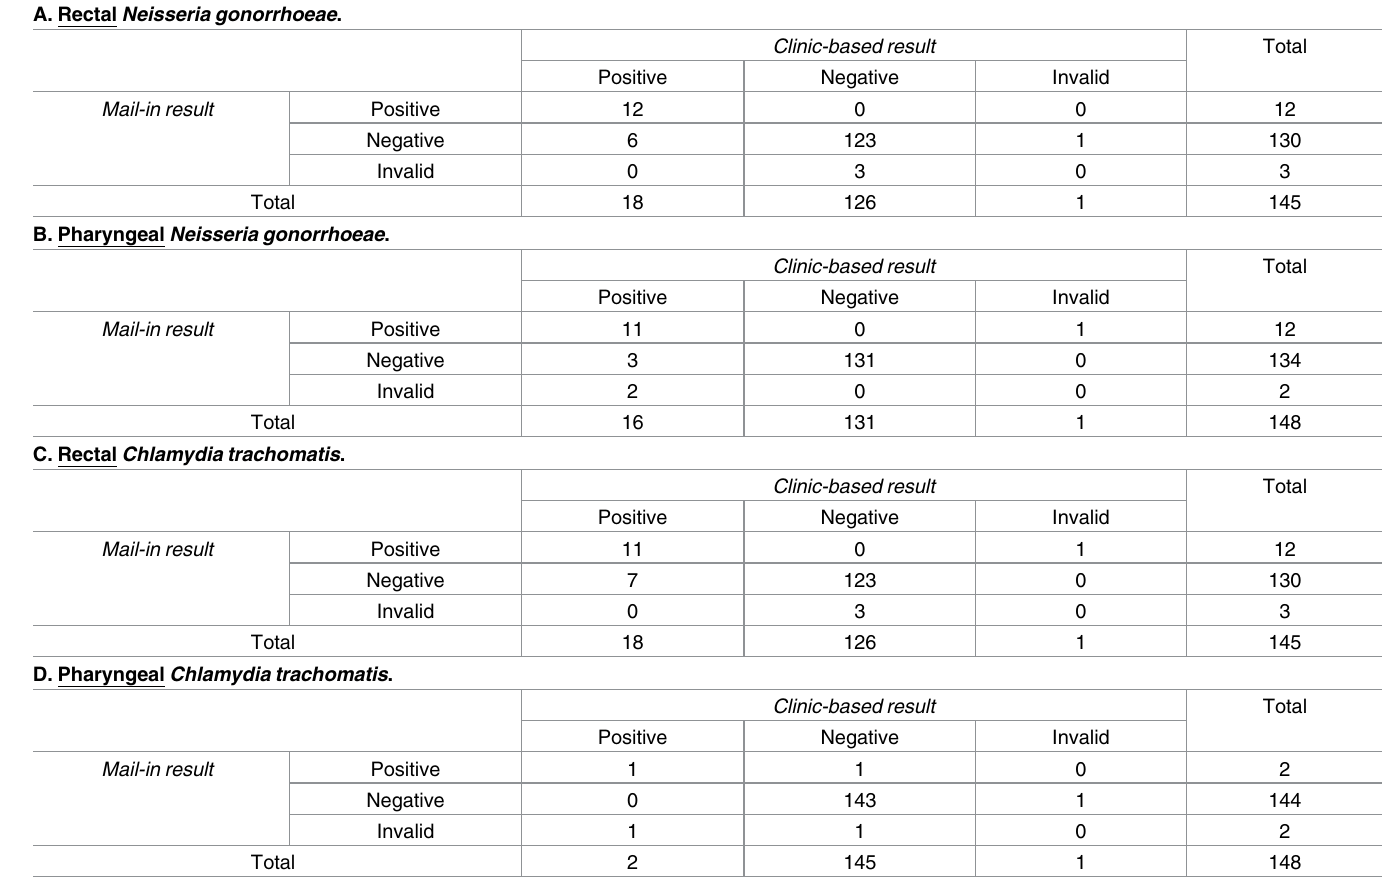
Table 2 provides a summary of the concordance between clinic-collected specimens and mail-in specimens by anatomic site. For CT, the concordance was 95.0% (95% CI: 90.0, 98.0) for all rectal tests, with 61.1% (95% CI: 35.8, 82.7) agreement among positive samples and